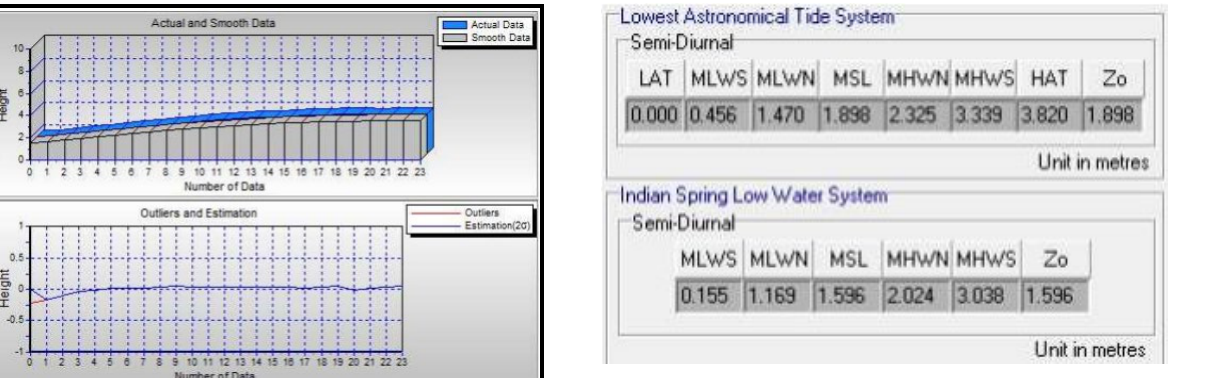
Figure 8. Tide analysis of water level with respect to LAT system (Top) and ISLW system (Bottom)